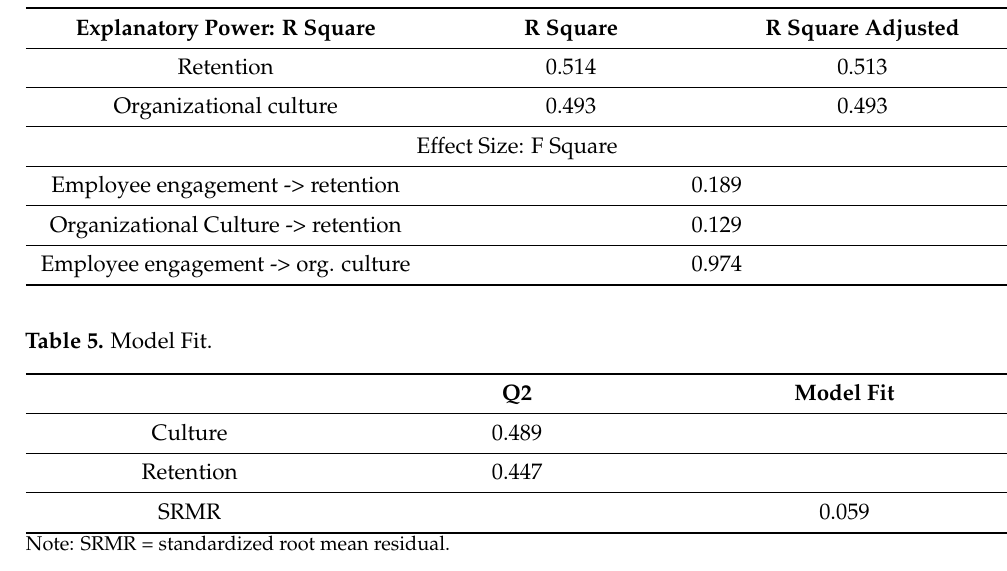
Table 4. Model explanatory power.